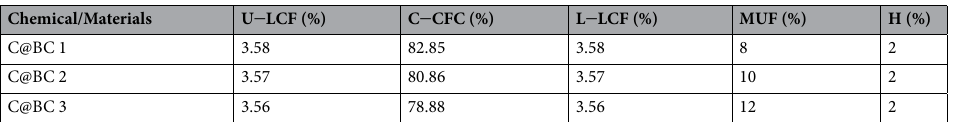
Table 2. Different recipes of coir fiber reinforced MUF polymeric biocomposites (C@BC 1, C@BC 2, and C@ BC 3). * U-LCF ‒ Upper layer incorporated by LCF; C-CFC ‒ Core layer incorporated by CFC; L-LCF ‒ Lower layer incorporated by LCF; MUF ‒ Melamine-urea–formaldehyde; H ‒ Hardener.